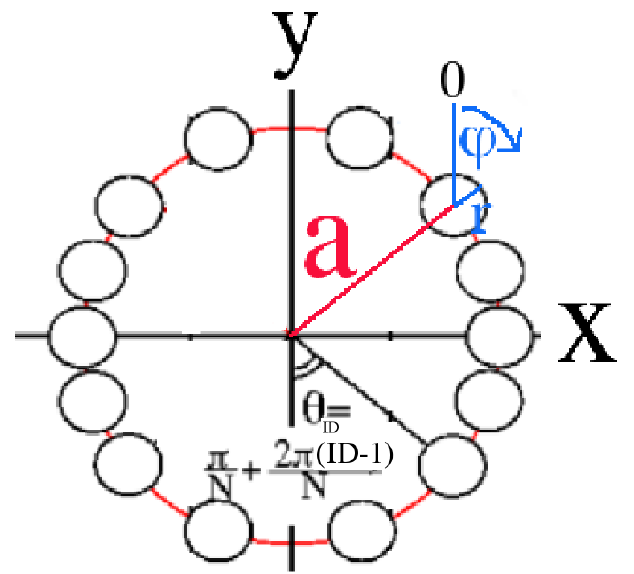
FIG. 4. (Color) The global coordinate and the local coordinate. The global coordinate ð x; y; z Þ specifies the Cu stripe and the local coordinate ð r; ’; z Þ specifies the position of the eddy current in one of Cu